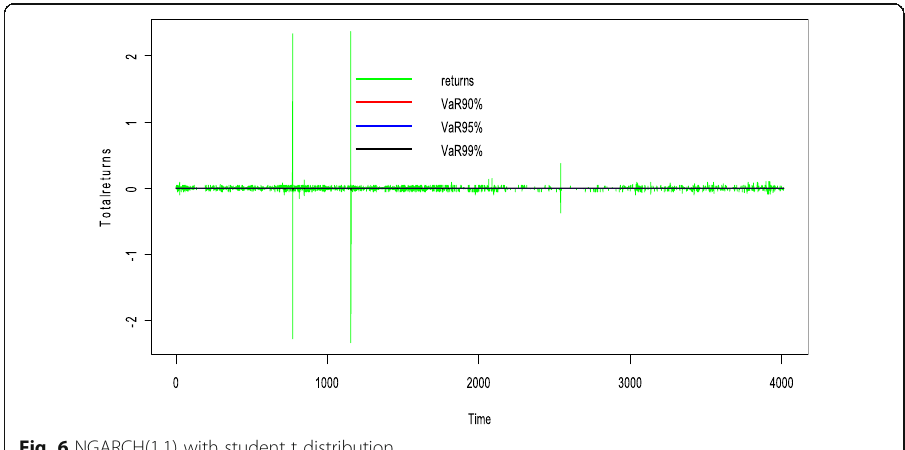
Fig. 6 NGARCH(1,1) with student t